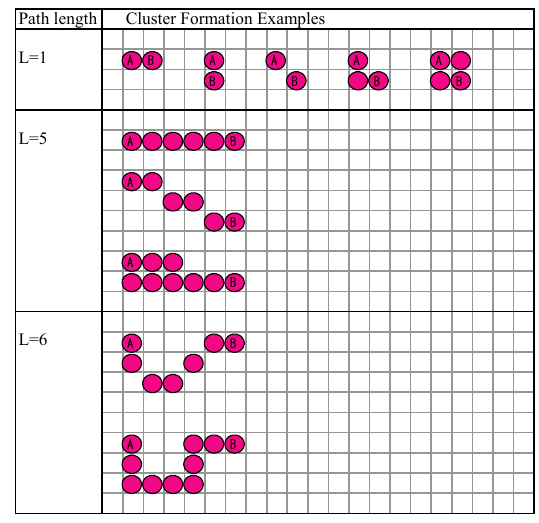
Figure 1. Determination of Path Length